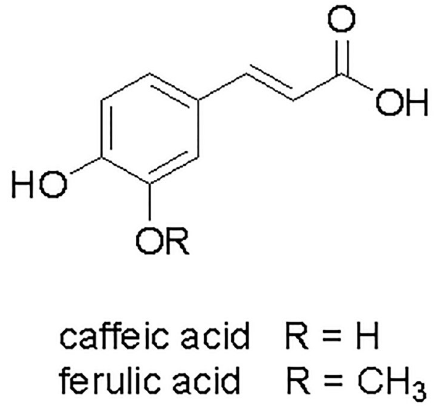
Figure 1. Chemical structures of caffeic acid (CA) and ferulic acid (FA), isolated from aerial parts of B.